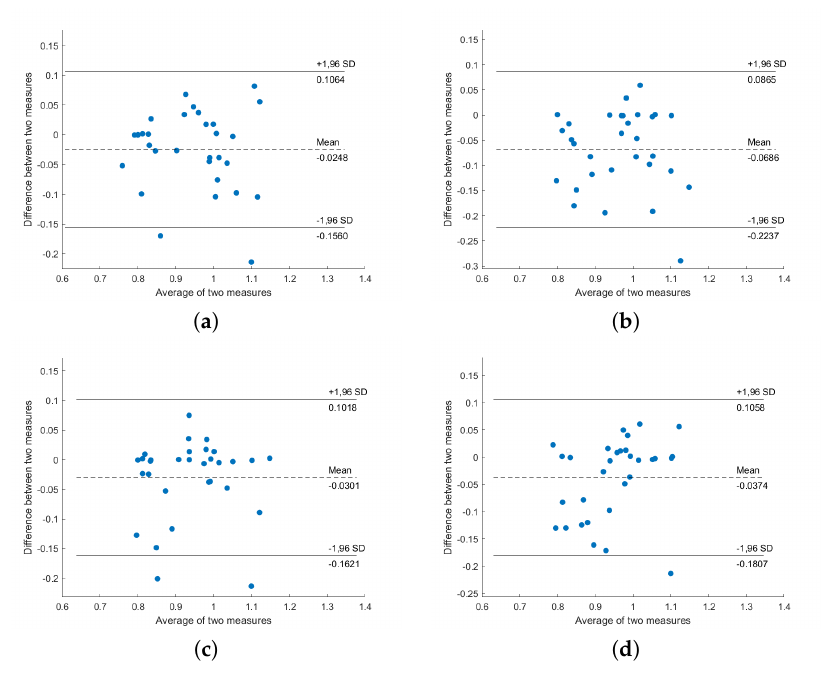
Figure A3. Bland–Altman plot of ECG-HRV and BCG-HRV, position “Right”: ( a ) S1; ( b ) S2; ( c ) S1 and S2; ( d ) all sensors.